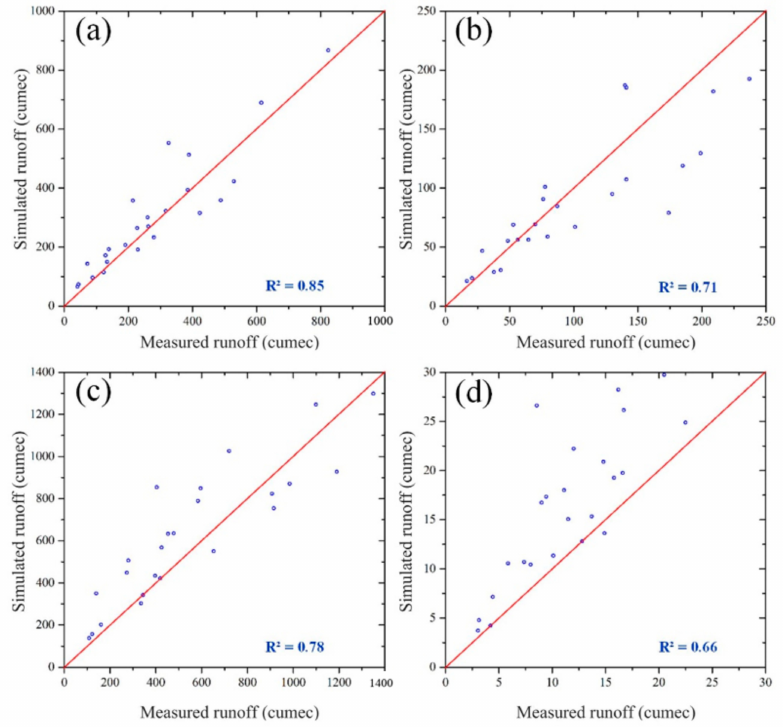
Figure 7. Scatter plot of simulated and measured monthly runoff of ( a ) Fenkeng station, ( b ) Hanlin- qiao station, ( c ) Xiashan station, and ( d ) Junmenling station in 2012 and